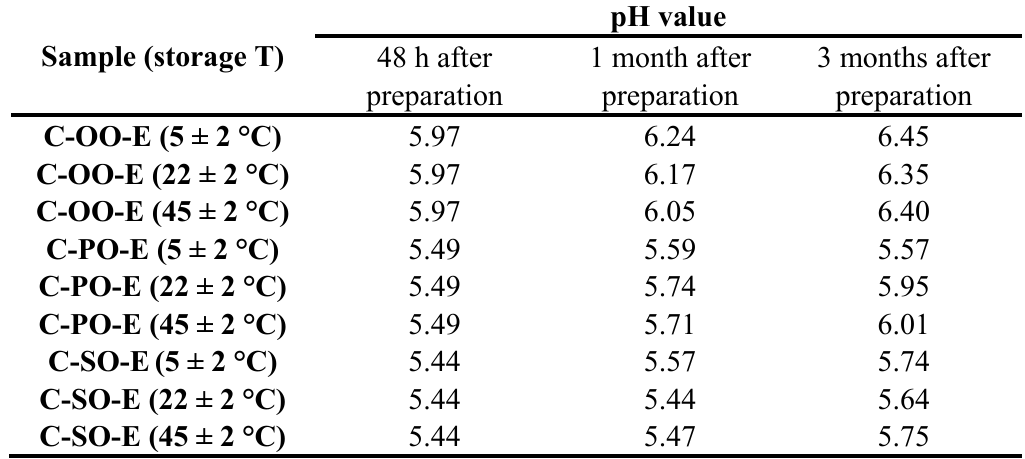
Table 2. pH values of the creams stored at 5 ± 2 °C, 22 ± 2 °C and 45 ± 2 °C as a function of time.